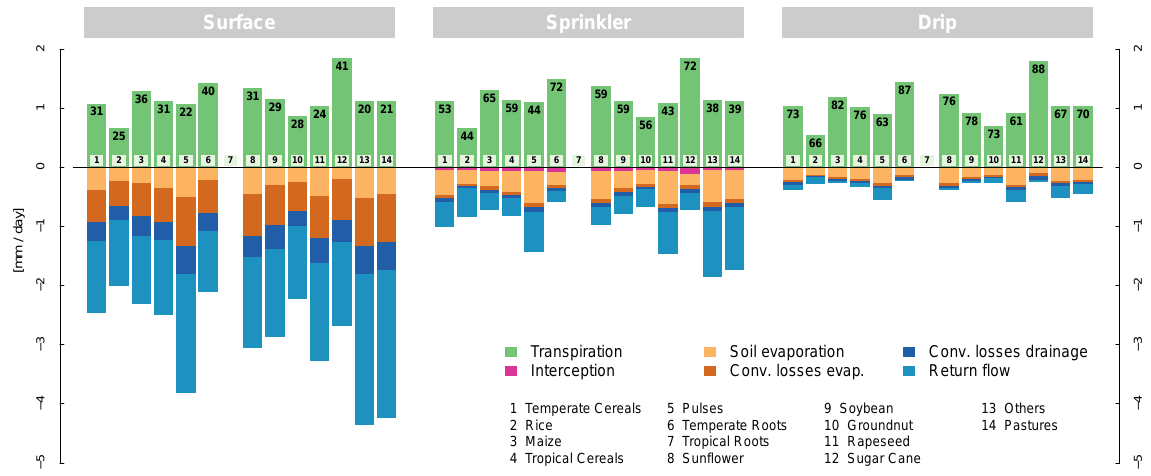
Figure 6. Decomposition of beneficial and non-beneficial irrigation water fluxes for each simulated CFT and irrigation system, in mmday − 1 averaged over the respective growing seasons and cultivated areas. For better comparability, each system is individually applied on all irrigated areas assuming the same, optimal management. The number at the top of each stack represent the CFT-specific beneficial irrigation efficiency ( E b , in %). Tropical roots are not irrigated.